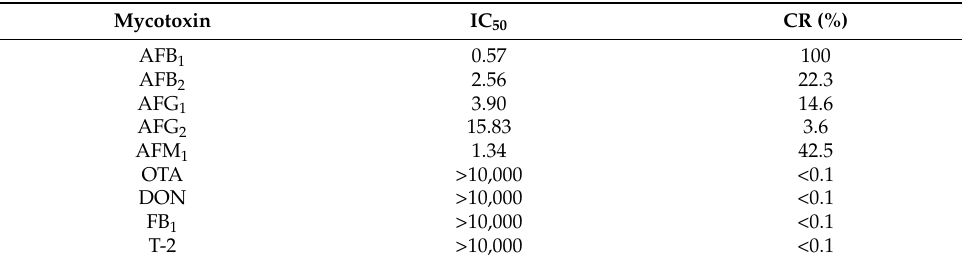
Table 2. The specificity of PMs-ICA for detection of AFB 1 .